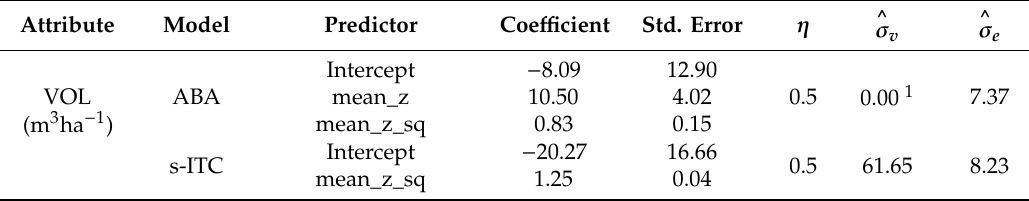
Figure 3. Pearson’s standardized residuals of ABA (green) and s-ITC models (orange) for the four forest attributes. Table 4. Selected predictors and parameter estimates for the s-ITC approach and the ABA.